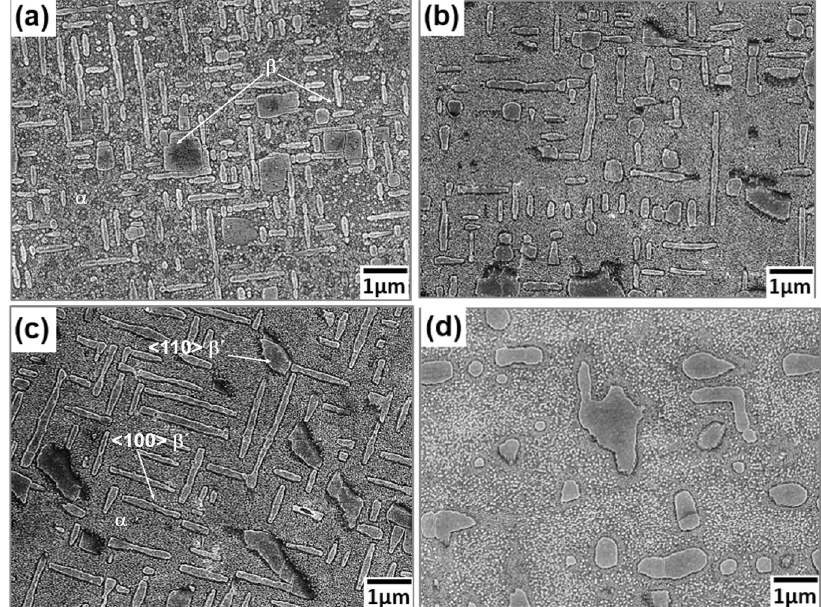
Figure 8. FEG-SEM micrographs of the precipitation evolution for the Fe-10at.%Ni-15at.%-5at.%CuAl alloy aged at 850 °C for (a) 10, (b) 25, (c) 50 and (d) 100